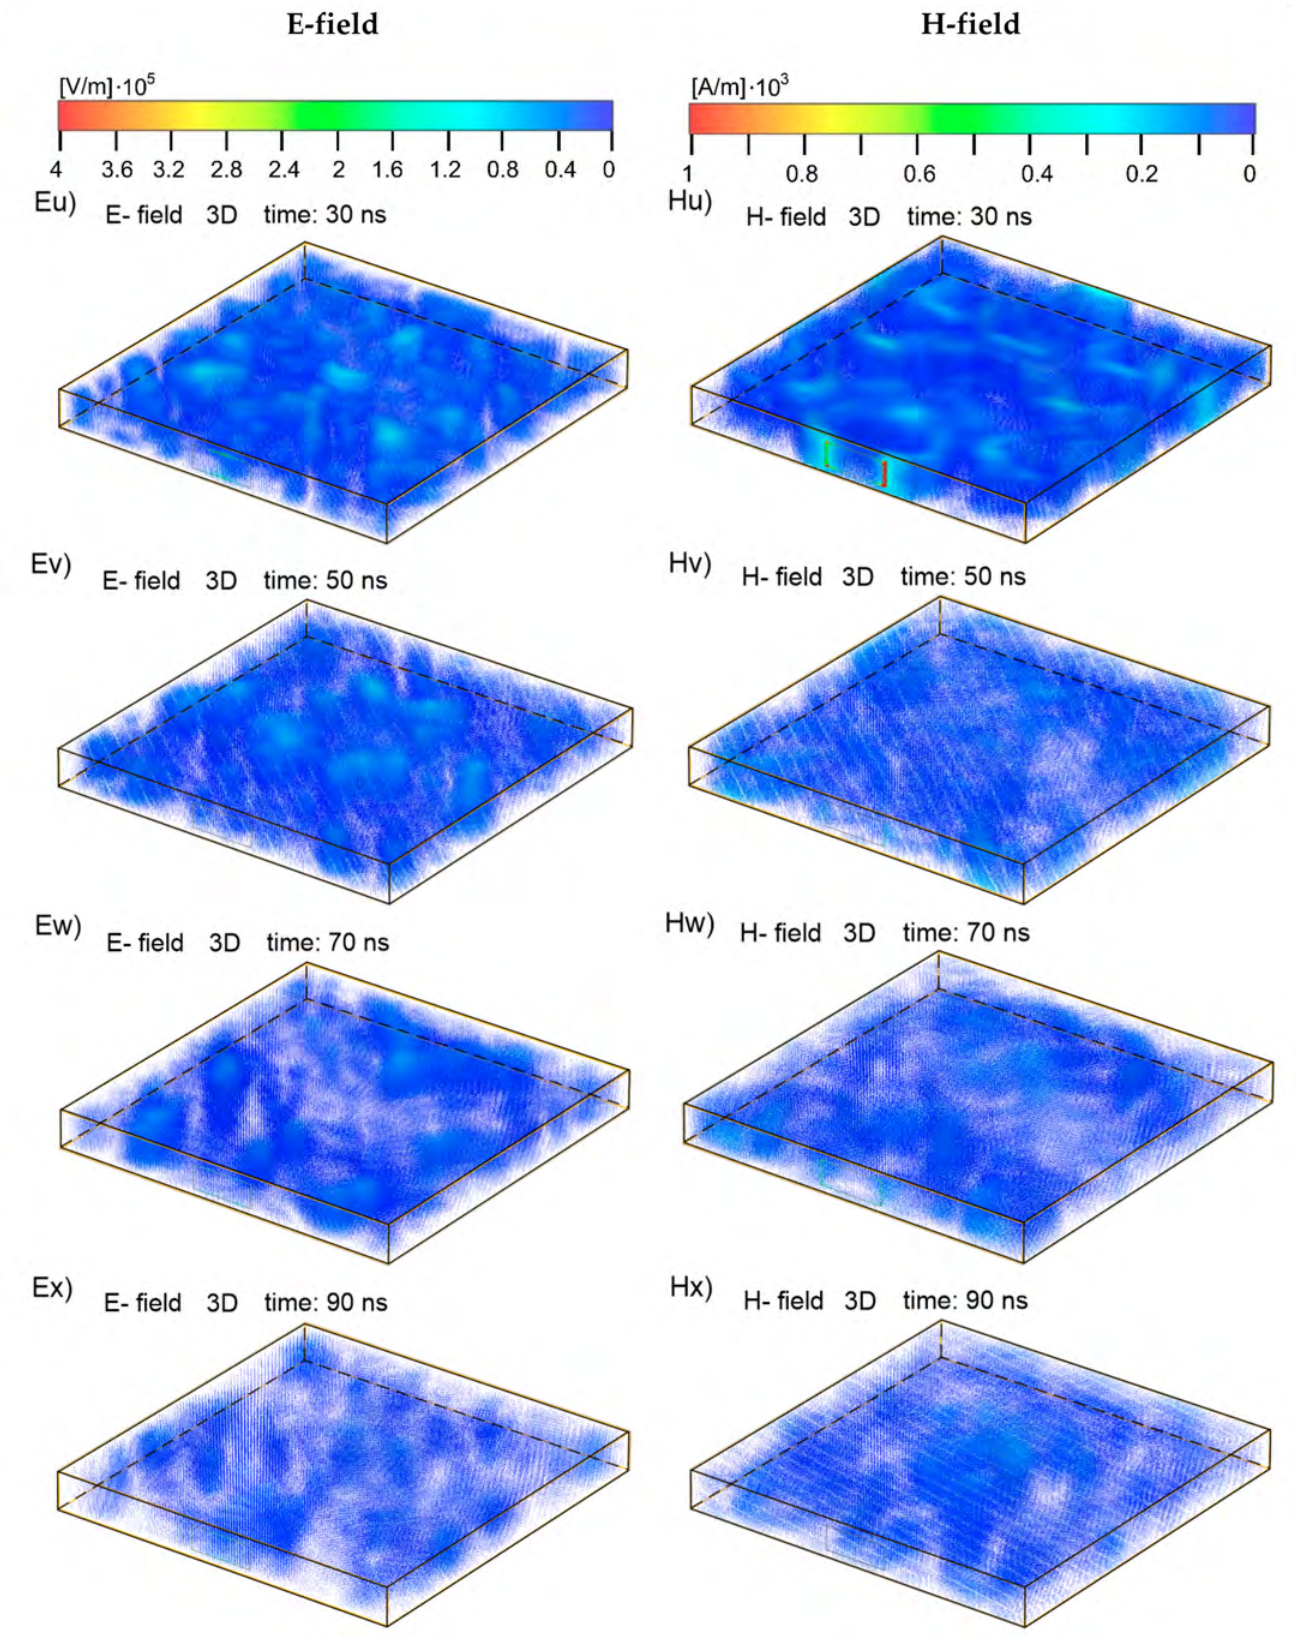
Figure 3. 3D development of the electric and magnetic fields in the enclosure. ( Left column )—the electric field amplitude; ( Right column }—the magnetic field amplitude. The current position of the incident pulse is